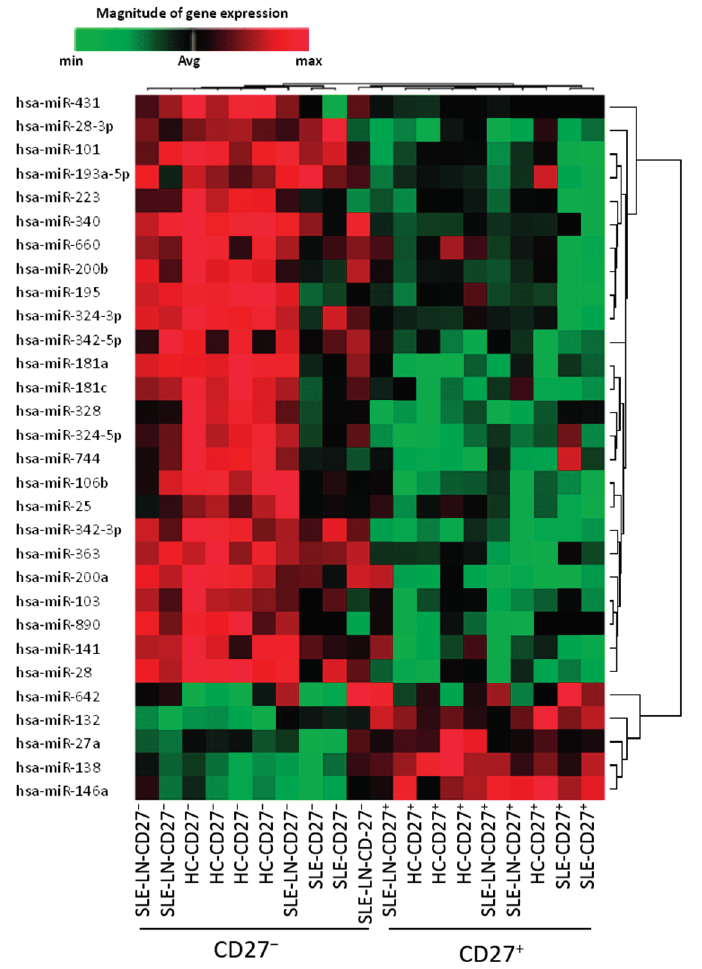
Figure 1. Hierarchical clustering of differentially expressed miRNAs in naive (CD27 − ) and memory (CD27 + ) B cells in healthy donors and SLE patients. The profiles of 30 microRNAs significantly differently expressed ( p < 0.01) between CD27 + and CD27 − cell samples isolated from six SLE patients and four healthy donors were visualized using a supervised heatmap (average linkage and Pearson’s correlation). Relative miRNA expression was calculated using the comparative threshold cycle (CT) method. For normalization, the mean CT value of all miRNA targets was used. Dendrograms indicate the correlation between groups of samples and miRNAs. Samples are in columns and transcripts in rows. Each row represents a single miRNA and each column represents an individual sample. The heat map shows the corresponding relative miRNA expression levels rendered to green-red color scale (red being high expression level (max), green being low expression level (min) and black being absence of detection